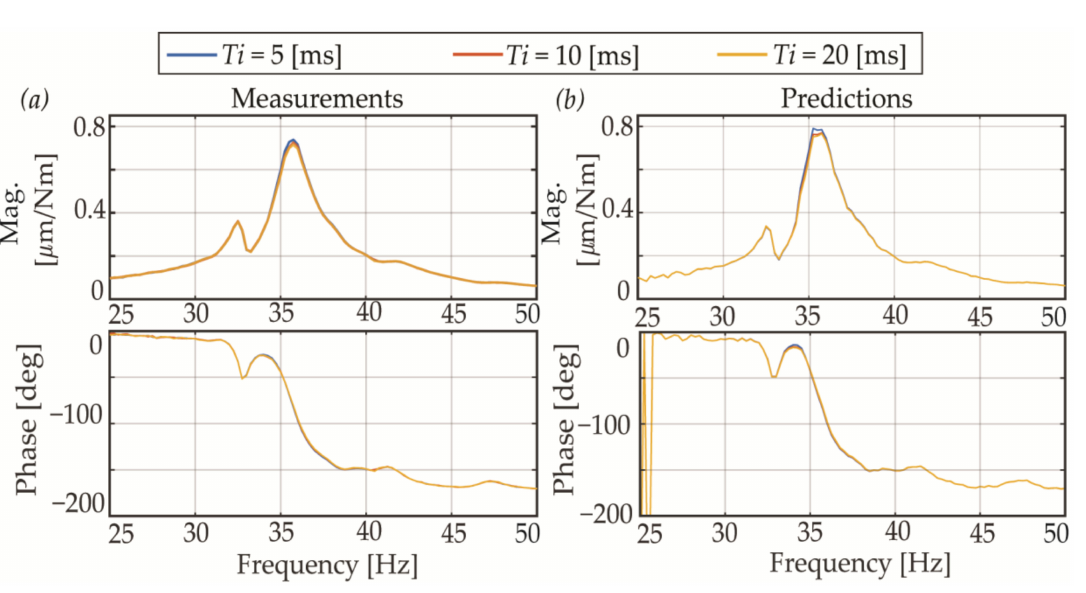
Figure 12. ( a ) Experimental, ( b ) Predicted closed-loop tool centre point